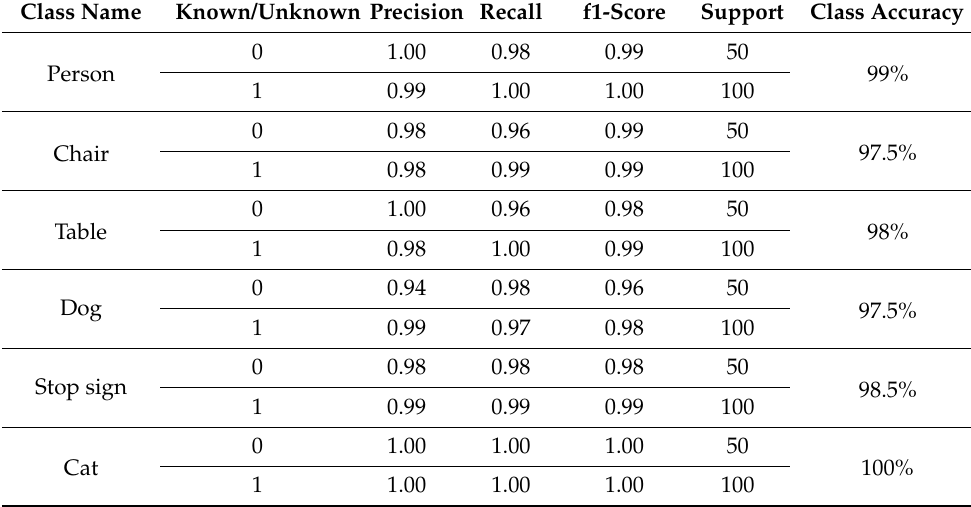
Figure 12. Classification accuracy for known and unknown data for each test case.